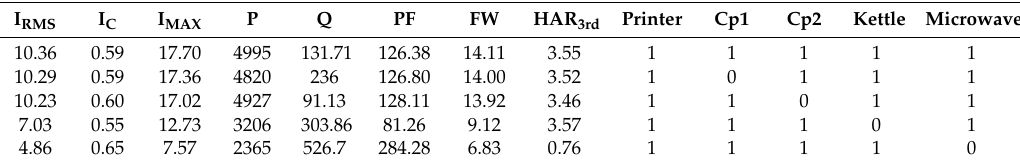
Table 1. Part of built data set.